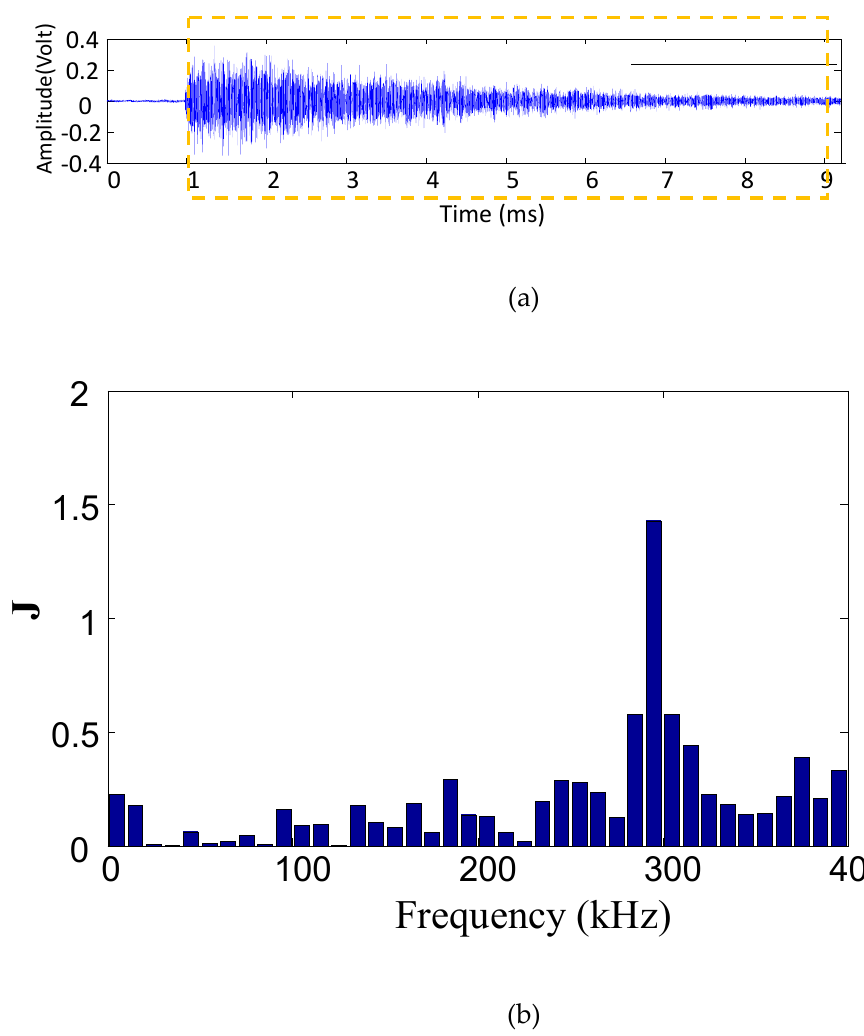
Figure 9. Raw signal and classification index for frequency features ( a ) raw signal for index calculation ( b ) classification index (signals collected throughout laser operation).